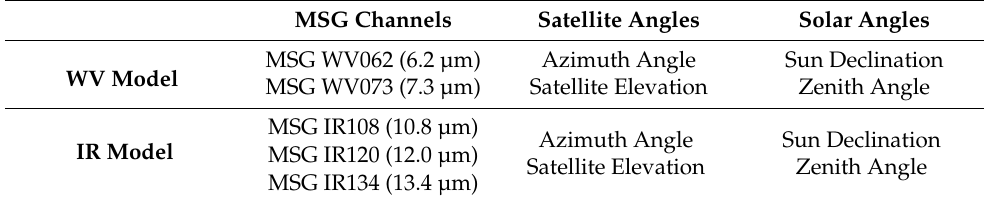
Table 2. Overview of RF predictor variables (WV and IR